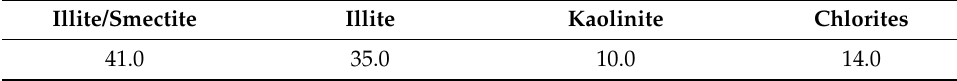
Table 2. X-ray diffraction analysis of the relative quantity of clay